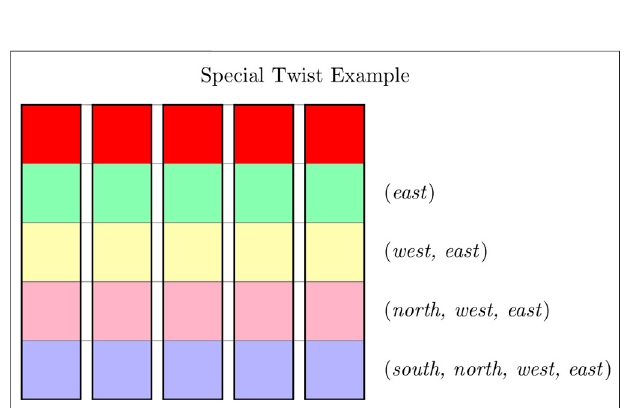
FIGURE 4 | Example of a speci fi c special twist for the “ Northern Border ” setup: All fi elds with the same color have the same twist regarding the action north (green: east → north , yellow: west → north , purple: north → and blue: south → north ). Thus all fi ve paths to the goal are the same and the resulting policy containing the scripts shown on the right side in information